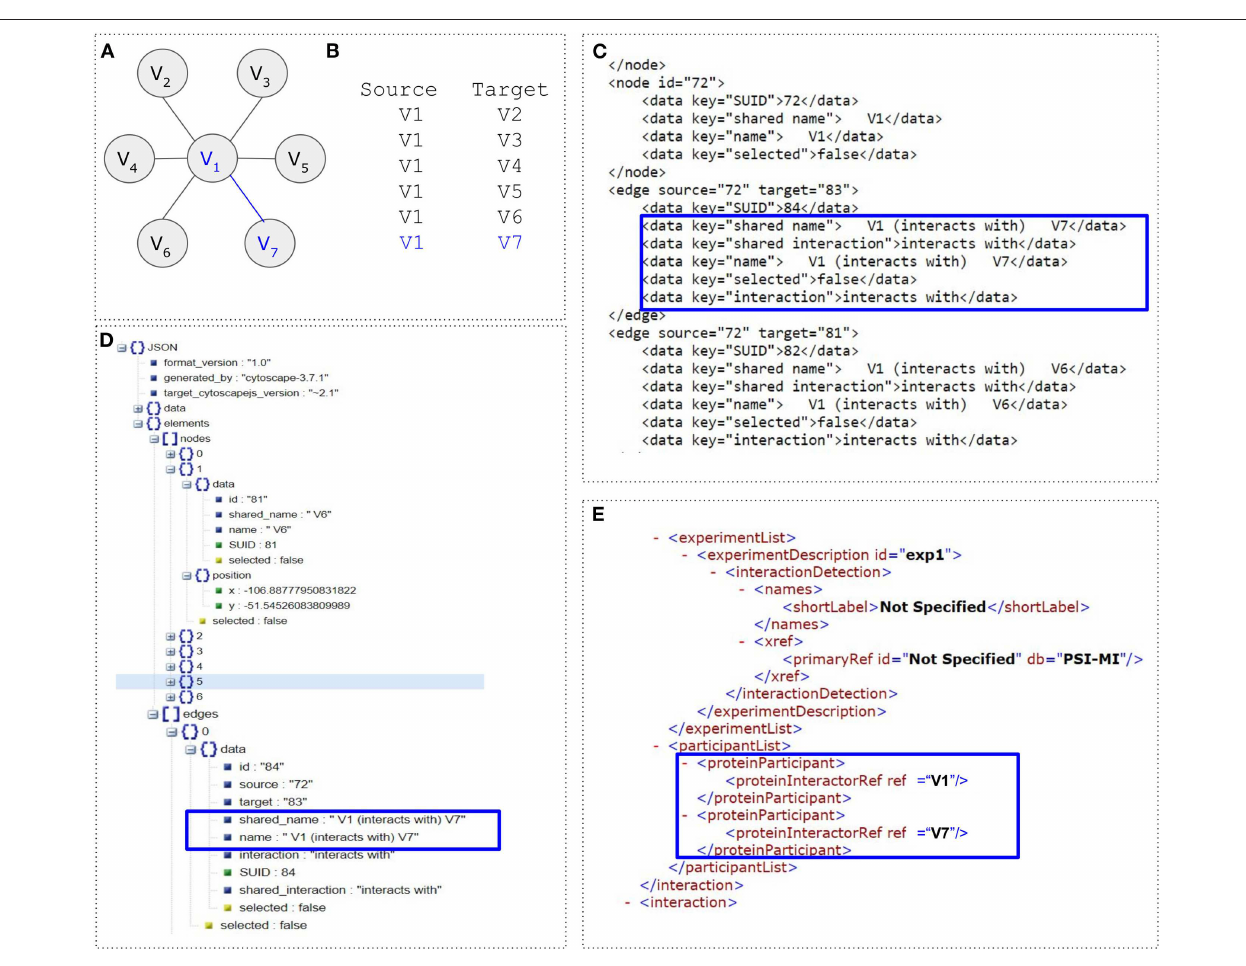
FIGURE 7 | Examples of file formats. (A) Simple undirected graph consisting of seven nodes ( V = 7) and six edges ( E = 6). (B) Network in Tab-delimited file format. (C) Network in GraphML file format. Blue box highlights the interaction between nodes V 1 and V 7 . (D) A cytoscape.js graph encoded in JSON. (E) Network in PSI-MI file